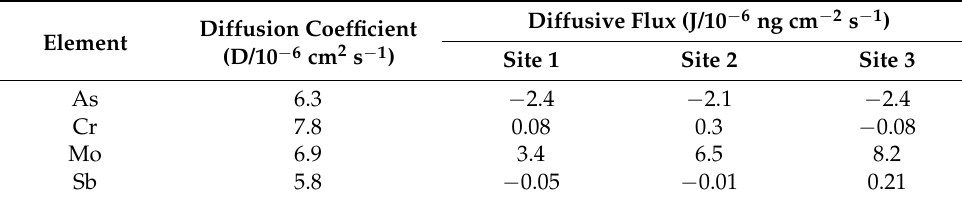
Table 4. Diffusion coefficients and derived values of average diffusive fluxes for sediment pore water at studied locations.